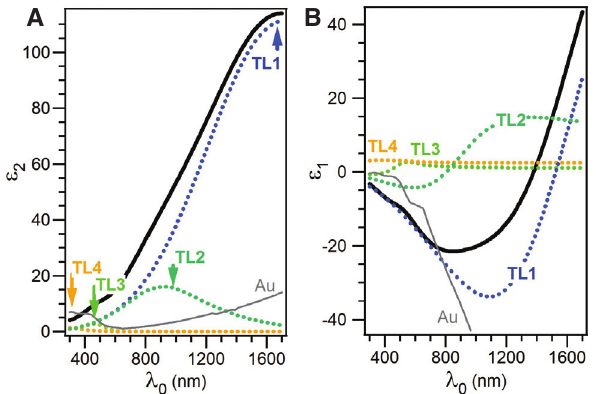
Figure 3 Deconstructing the dielectric function of solid Bi in the near UV-to-near IR range. Spectra of the imaginary part ε (A) and 2 real part ε (B) of the dielectric function of solid Bi (thin film grown 1 by pulsed laser deposition, data taken from [66] – black lines) and real and imaginary part of its Kramers-Krönig-consistent Tauc-Lor- entz components (TL1, TL2, TL3, TL4). The spectra are dominated by TL1 that accounts for the strong loss band peaking around 1700 nm ( ε spectrum) and the negative ε values in the near UV-to-near IR. 2 1 The dielectric function of Au taken from the Palik database is also shown (gray